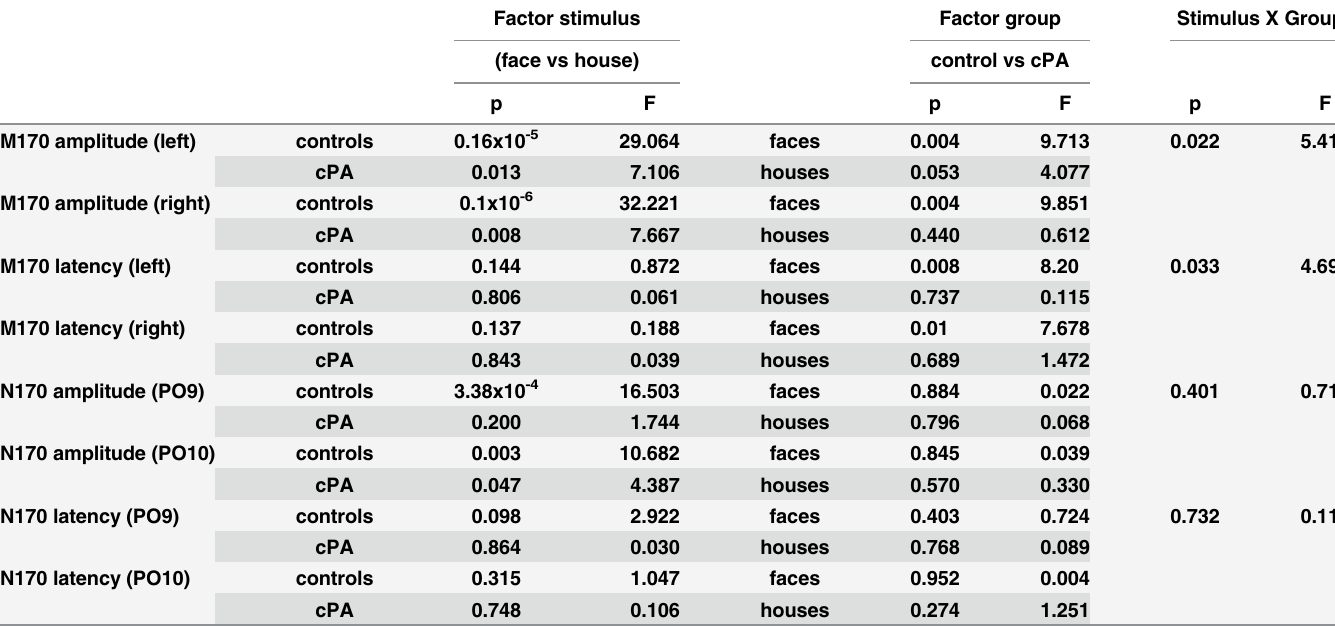
Table 3. Detailed results from the mixed ANCOVA are shown for experiment 2 (stimuli attended); MEG: upper half; EEG: lower